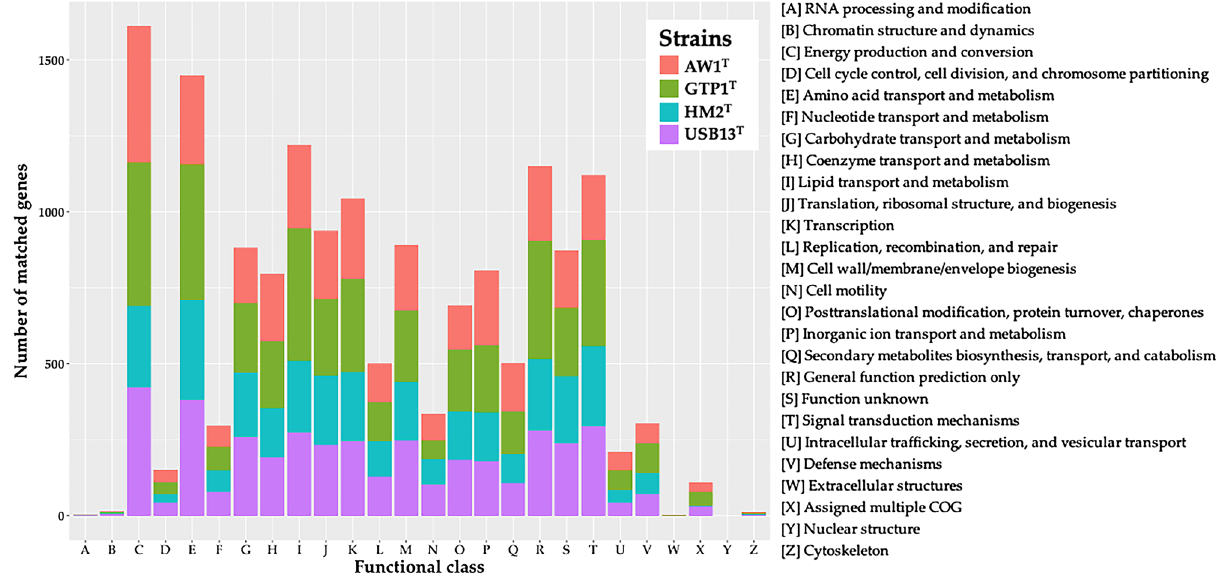
Figure 4. Comparison of total number of matched genes of strains USB13 T , AW1 T , GTP1 T , and HM2 T according to functional classes based on Cluster of Orthologous Groups of proteins (COG) predictions 48 .